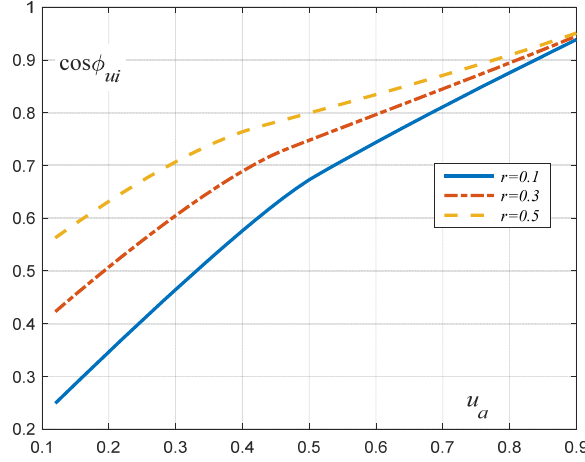
Figure 10. Power factor of a circuit with a nonlinear load as a function of load voltage amplitude and resistance.